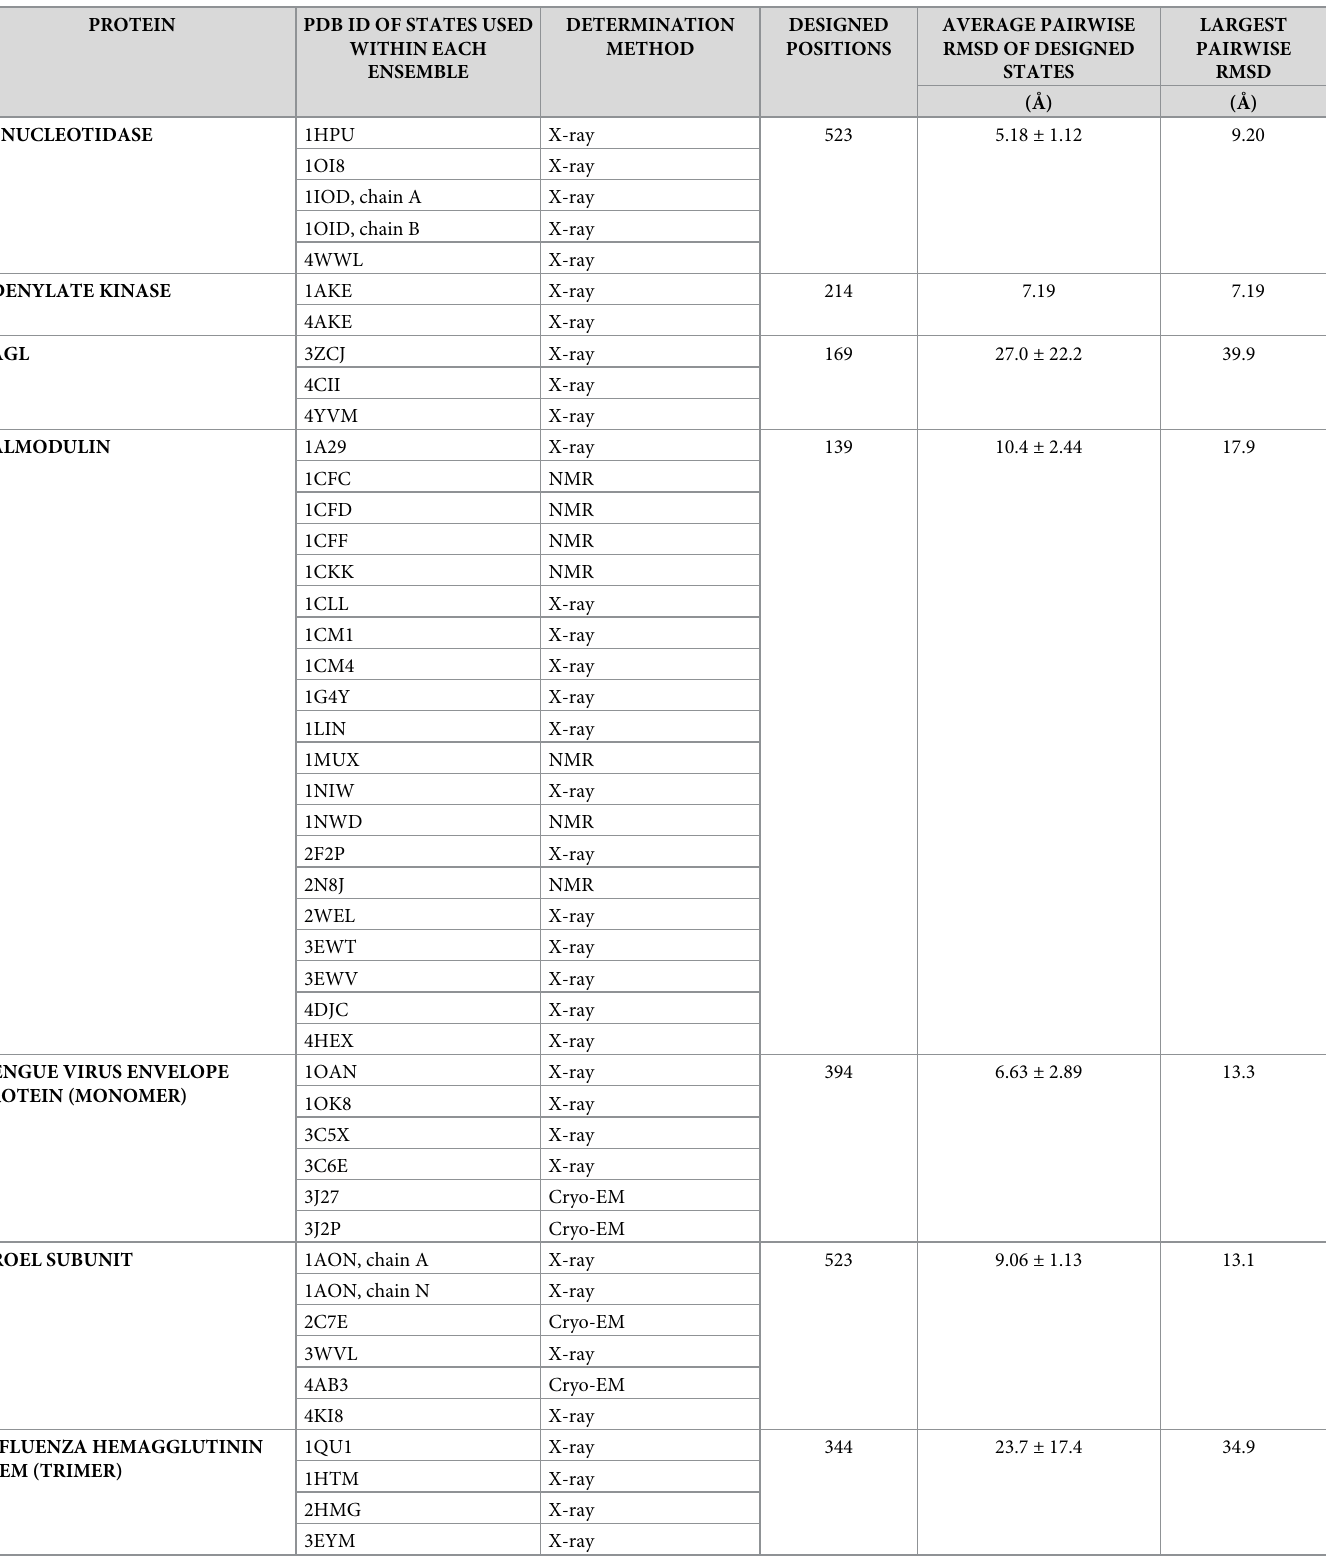
Table 1. Proteins used in conformation-dependent sequence tolerance